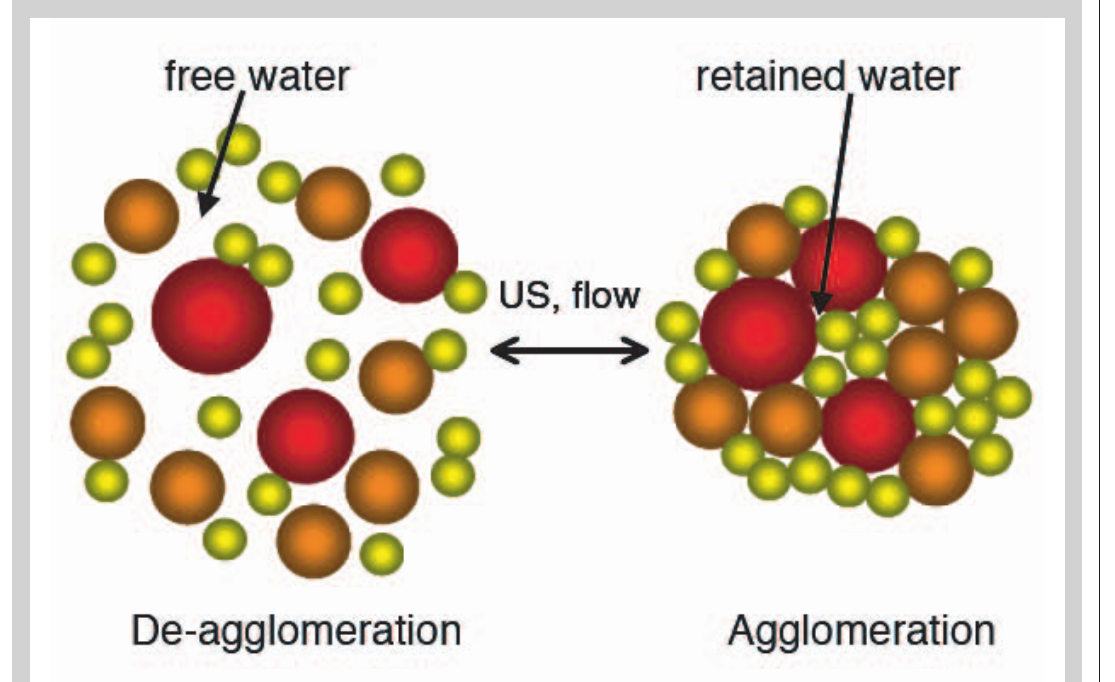
Figure 12: Effect of a ultrasonic treat- ment and/or flow on de- agglomeration and agglom- eration mechanisms and, therefore, on the structure and flow-behaviour of sus-